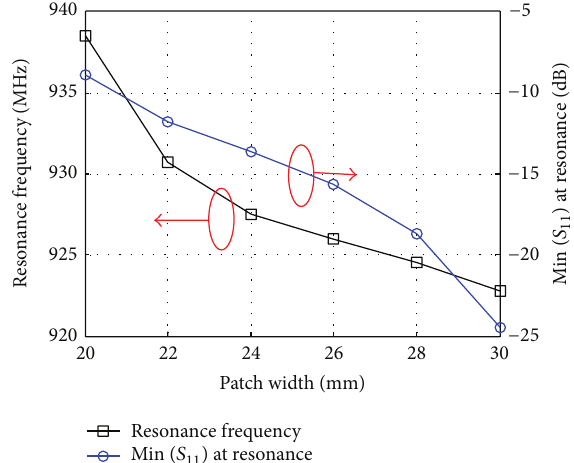
Figure 3: Simulated antenna resonant frequency and minimum reflection coefficient within a specific bandwidth versus variation of patch width 𝑊